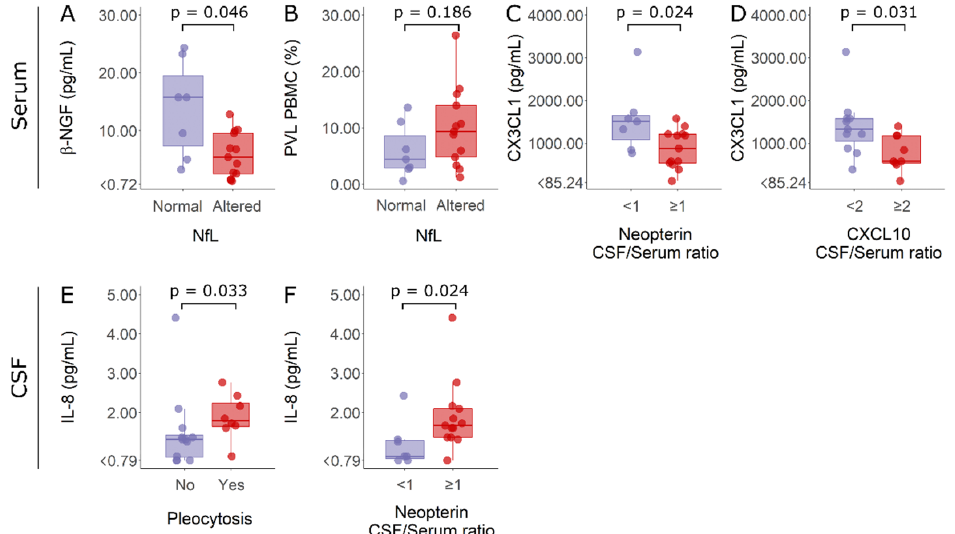
Figure 7. Serum β -NGF and fractalkine/CX3CL1 levels, HTLV-1 proviral load, and CSF IL-18 concentration in HAM/TSP patients according to altered markers of inflammation and neurodegeneration. Individuals were separated according to normal ( n = 7, purple) and altered ( n = 13, red) CSF levels of neurofilament light (NfL) proteins and considering active neuroinflammation as a CSF/serum ratio of neopterin ≥ 1 ( n = 13, red) or CXCL10 ≥ 2 ( n = 9, red). Patients with a CSF/serum ratio of neopterin < 1 ( n = 7, purple) or CXCL10 < 2 ( n = 11, purple) were considered to have low neuroinflammatory activity. Finally, individuals were also discriminated by normal CSF cell counts (<5 cells/mm 3 ) ( n = 12, purple) or pleocytosis ( n = 8, red). ( A ) Serum β -NGF, ( B ) HTLV-1 proviral load (PVL), and ( C , D ) serum fractalkine/CX3CL1 levels were compared between groups with Student’s t -test. ( E , F ) CSF IL-18 levels were compared between groups with the Mann–Whitney test. Differences with p < 0.05 were considered significant.